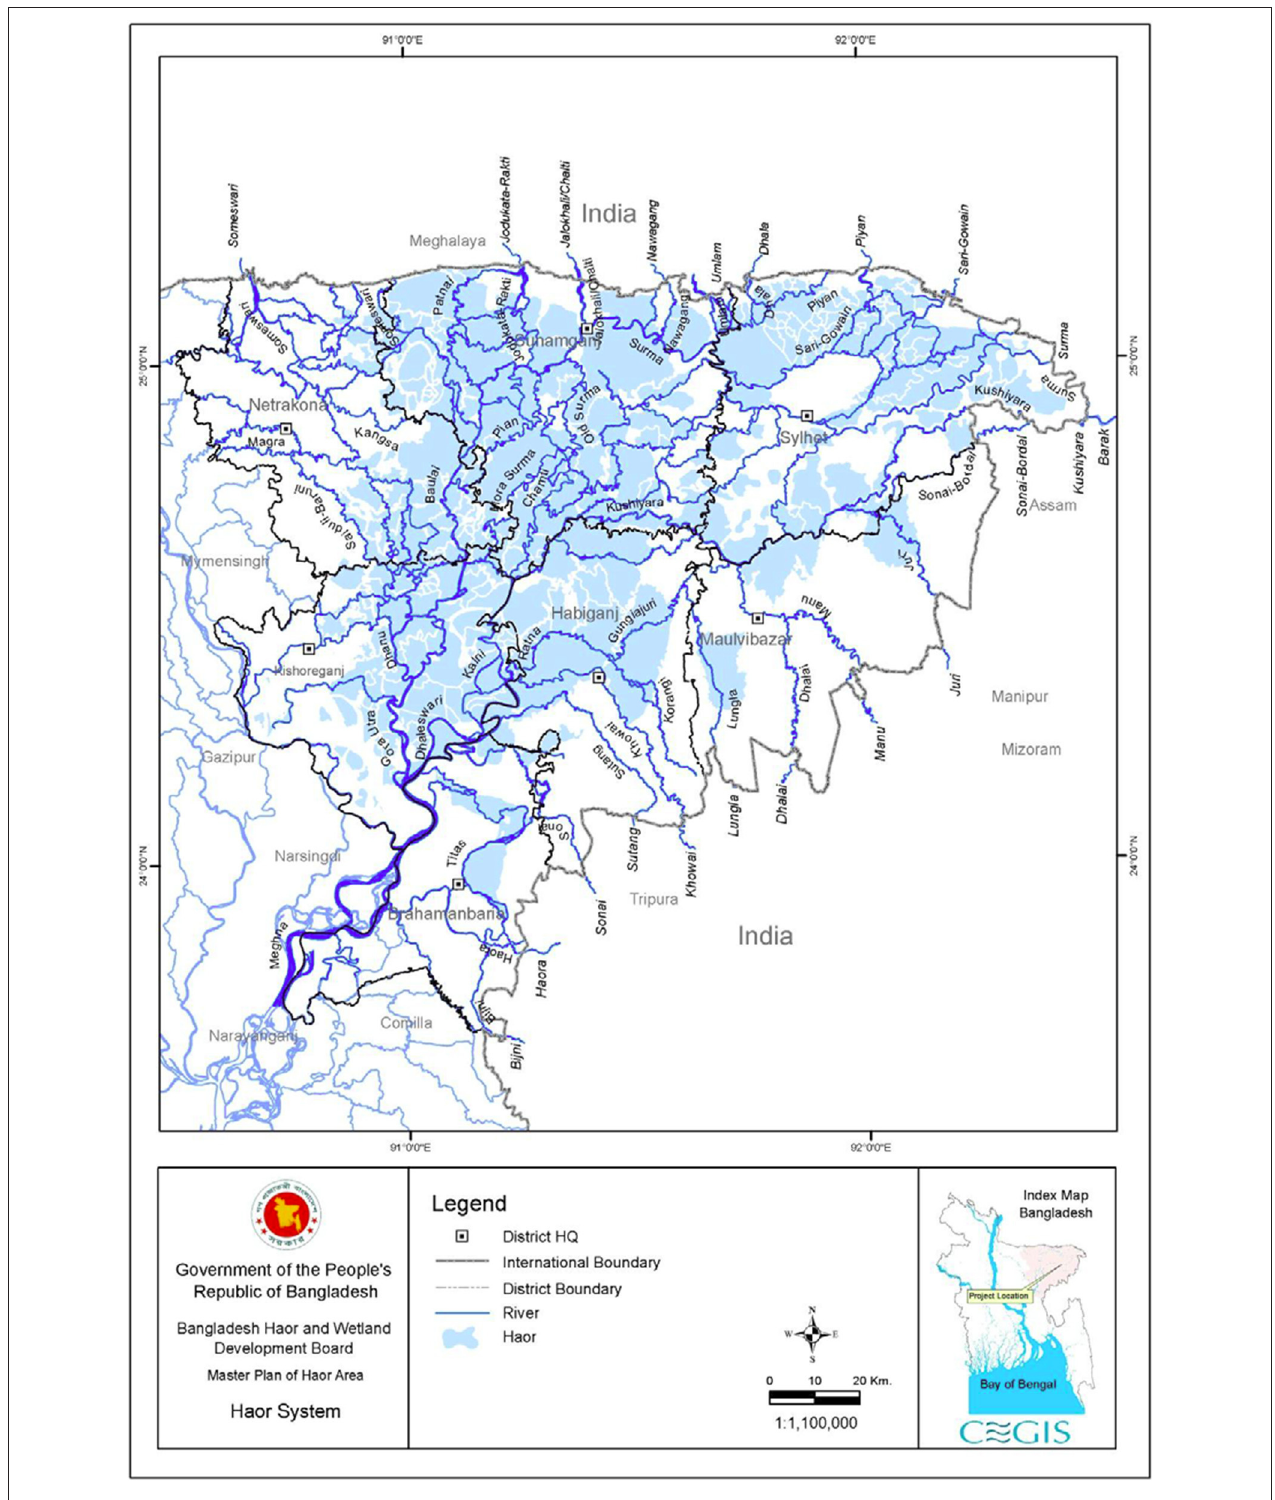
FIGURE 1 | Haor areas of the northeastern floodplain of Bangladesh [Source: (Ministry of Water Resources (MoWR), 2012)].